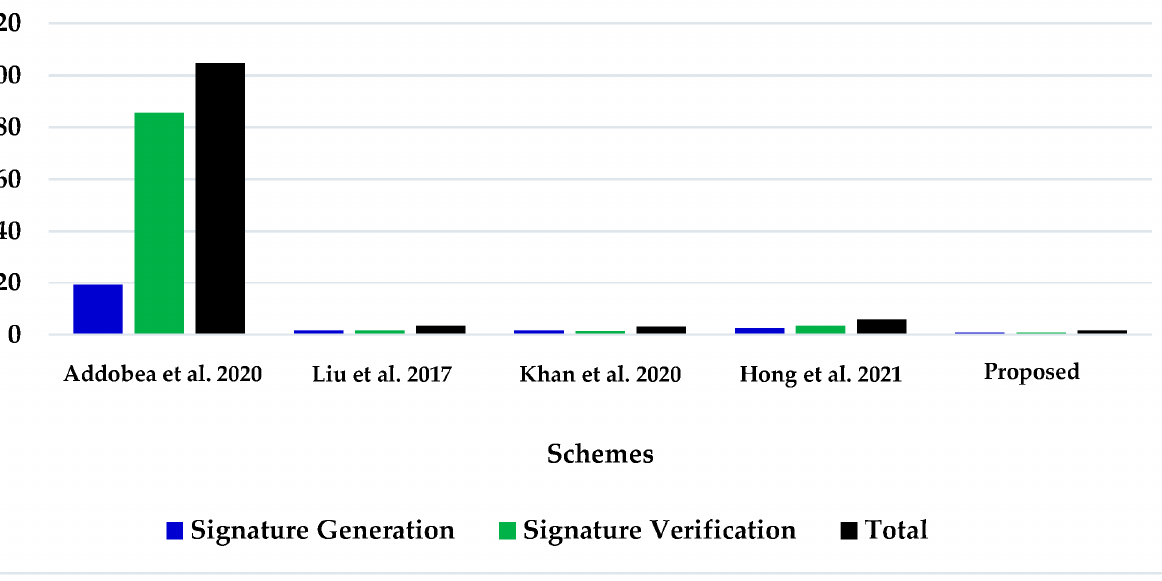
Figure 5. Computation time evaluation [19,20,22,24]. Table 4. Computation of the costs of both online and offline signature generation.